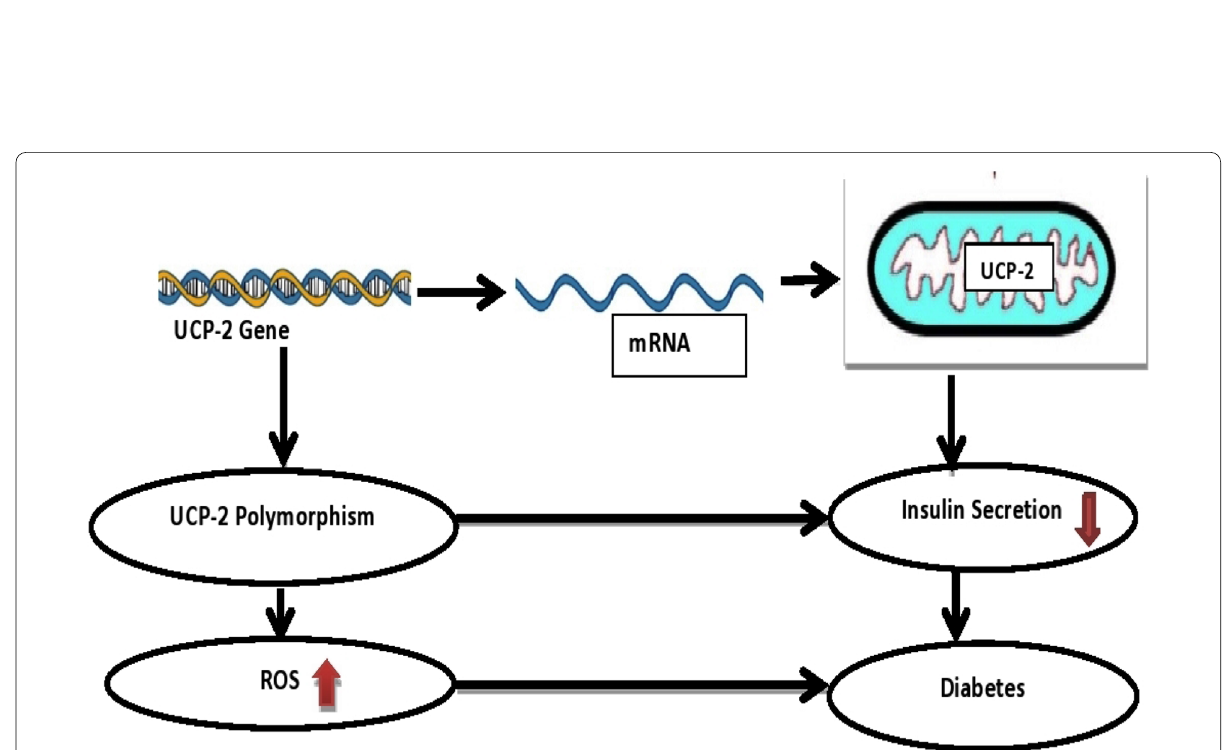
Fig. 4 UCP2 proton leak pathway as an imperious initiator of β-cell dysfunction. UCP: Uncoupling Protein; mRNA: messenger ribonucleic acids; ROS: Reactive Oxygen